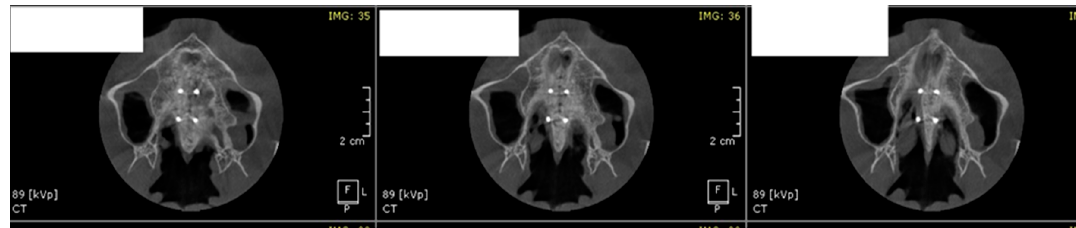
Figure 6. Interincisal diastema formation. ( a )Axial view ( b ) Frontal view ( c ) Cross-sectional view. Figure 7. Rendering images showing cortico-puncture perforations and micro-implants in position.